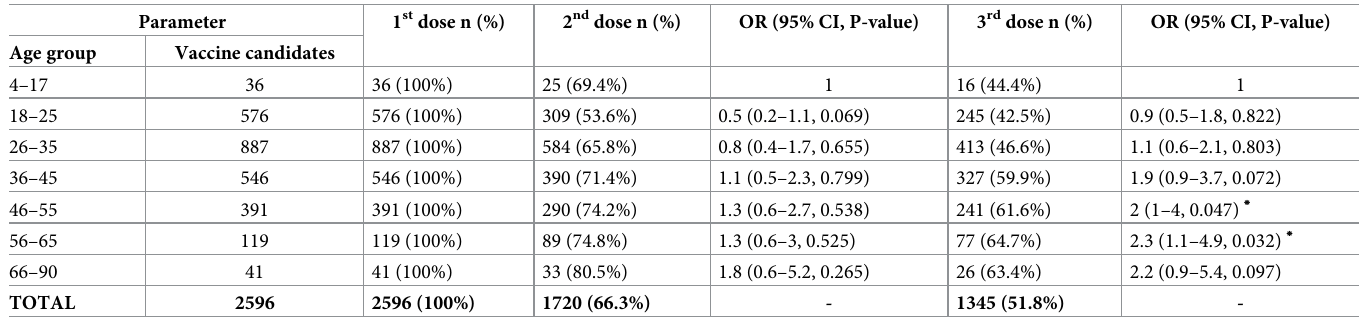
Table 2. HBV vaccination compliance rates according to ages among outpatient clinic attendees in Kenya in 2015.